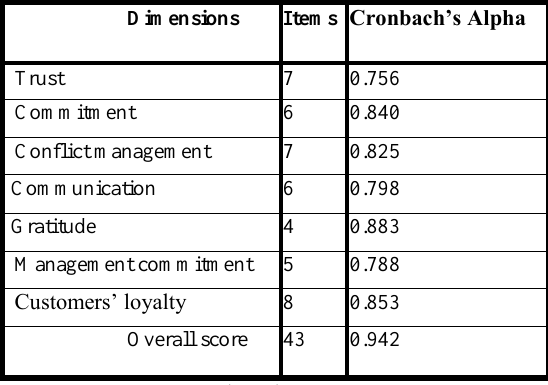
Table 2: Reliability Analysis: Cronbach’s Alpha Value